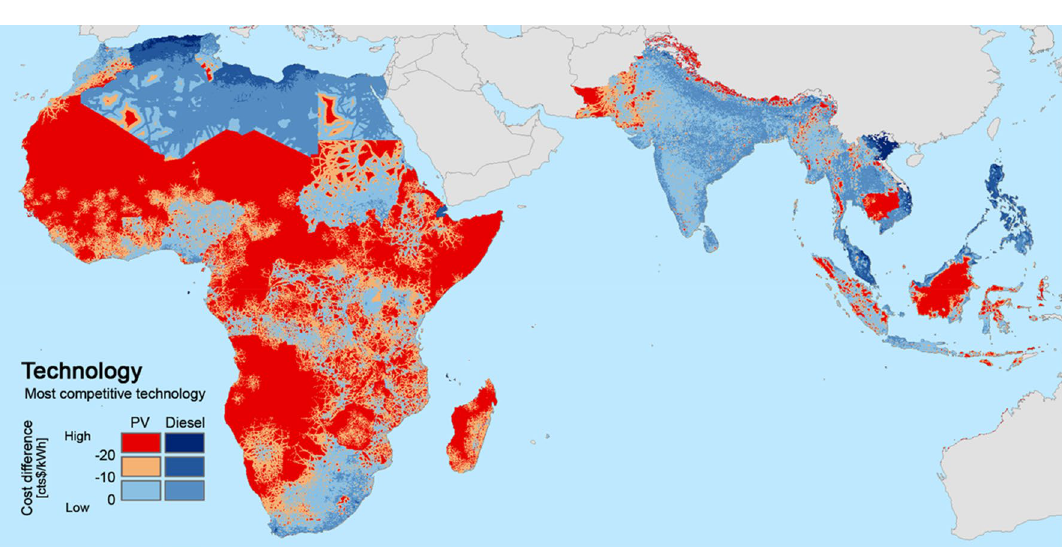
Figure 4. Location-specific estimates of the relative cost of solar PV versus diesel-based minigrids in the adverse PV conditions scenario. Red-coloured areas are those where PV minigrid investments represent no-regrets options. In these areas, even under adverse PV conditions, PV generation costs are at least US$0.20 / kWh cheaper than diesel generation. ArcGIS 10.6 (https ://deskt op.arcgi s.com/) was used to calculate the values and generate the map. GIMP 2.10 (https ://www.gimp.org) was used for image